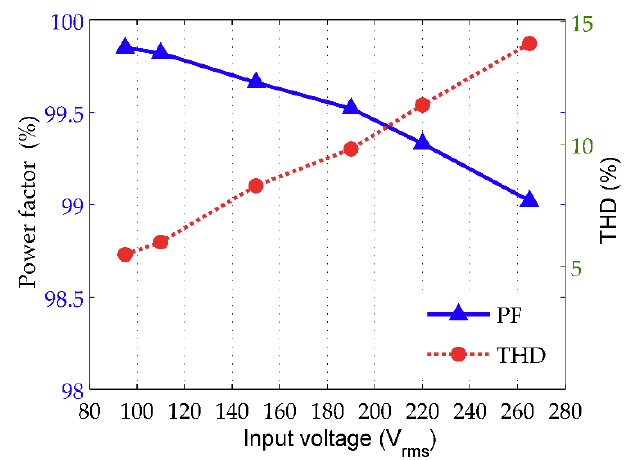
Figure 11. The simulated PF and THD of the proposed bridgeless high step-up gain PFC converter.